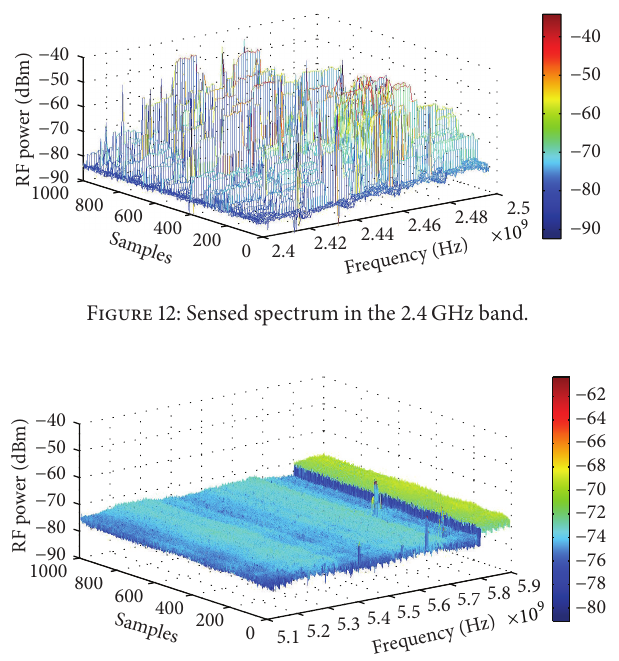
Figure 13: Sensed spectrum in the 5 GHz band.